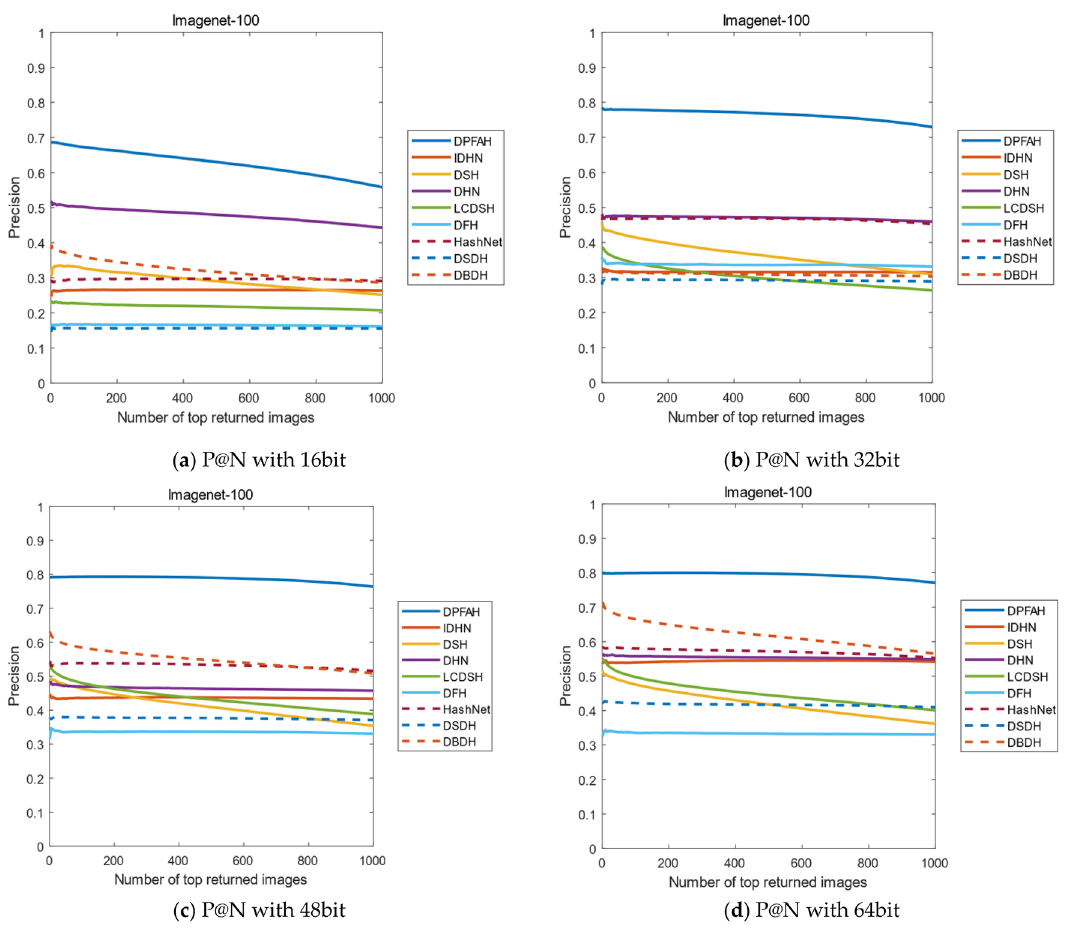
Figure 14. ( a–d ) Represent the P@N curves on Imagenet-100 of all methods with different bits. (Created by “matlab R2019a” url: https:// ww2. mathw orks. cn/ produ cts/ matlab.